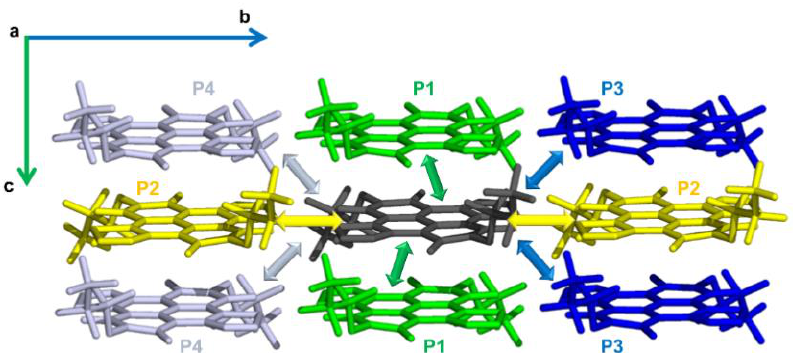
Figure 3. The most relevant charge transport paths (from the central dark gray molecule), namely P1 (green), P2 (yellow), P3 (blue), and P4 (light gray), shown within a portion of the N-NDTI crystal. The view is along the a axis.